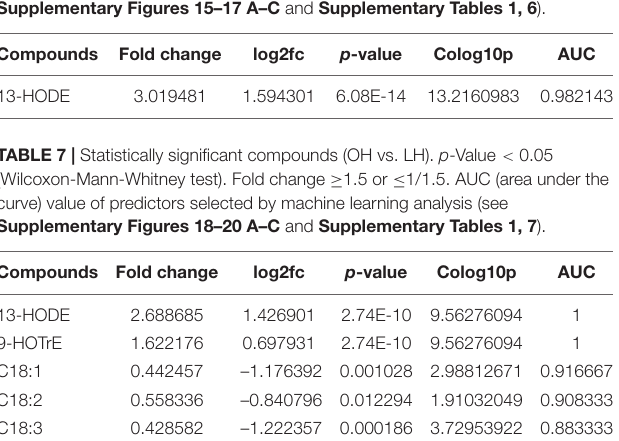
TABLE 8 | Statistically significant compounds (DX vs. NDX). P -value < 0.05 (Wilcoxon-Mann-Whitney test). Fold change ≥ 1.5 or ≤ 1/1.5. AUC (area under the curve) value of predictors selected by machine learning analysis (see Supplementary Figures 21–23 A–C and Supplementary Tables 1, 8 ).